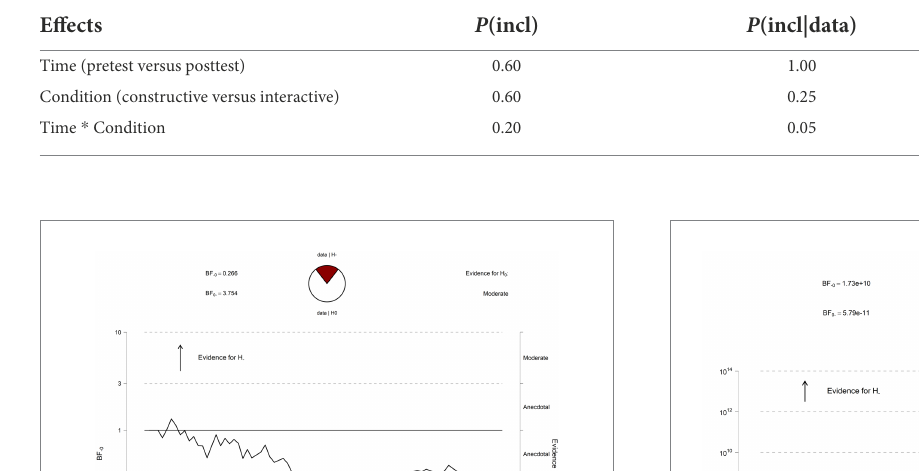
TABLE 3 Analysis of effects for the Bayesian repeated measures ANOVA on knowledge.